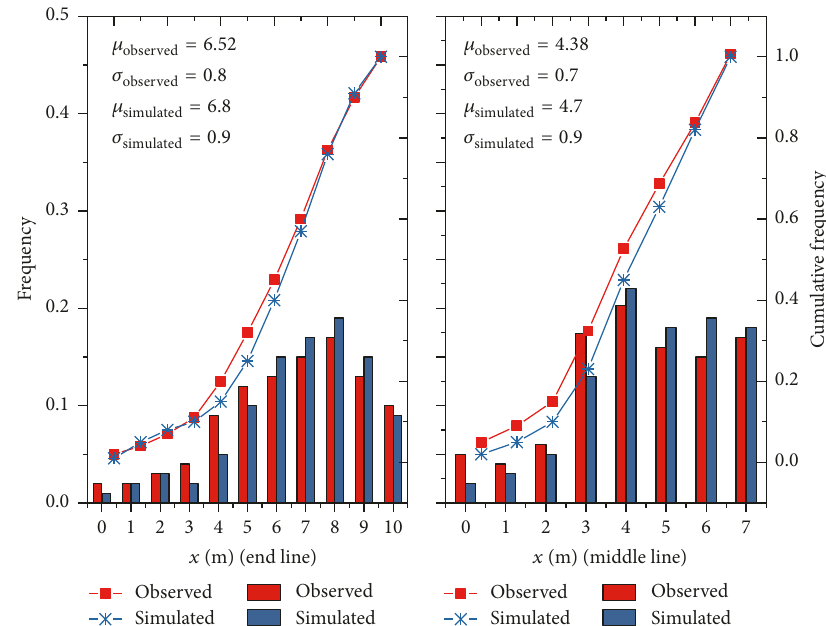
Figure 13: Comparison of simulated and observed crossing positions.